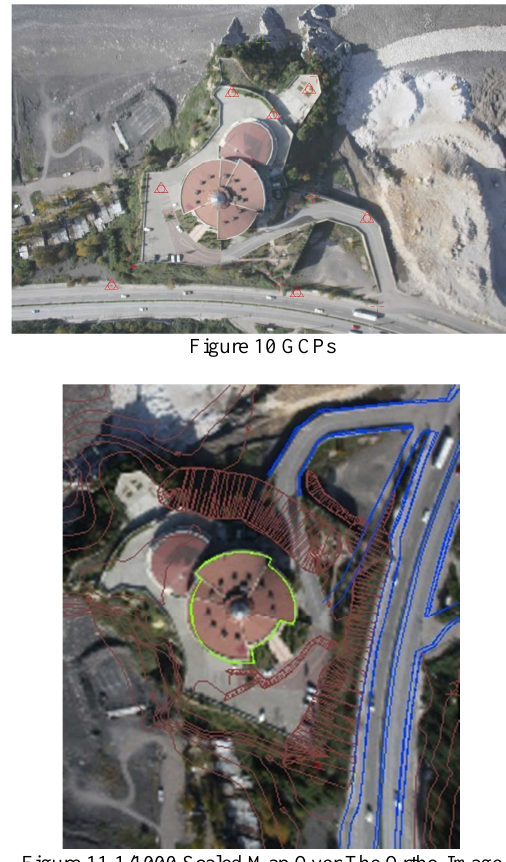
Figure 11 1/1000 Scaled Map Over The